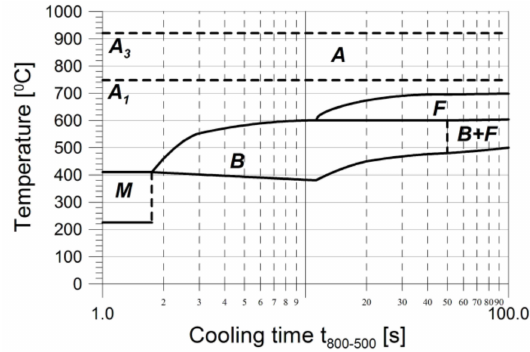
Figure 8. Time-temperature-transformation (TTT) diagram of S355